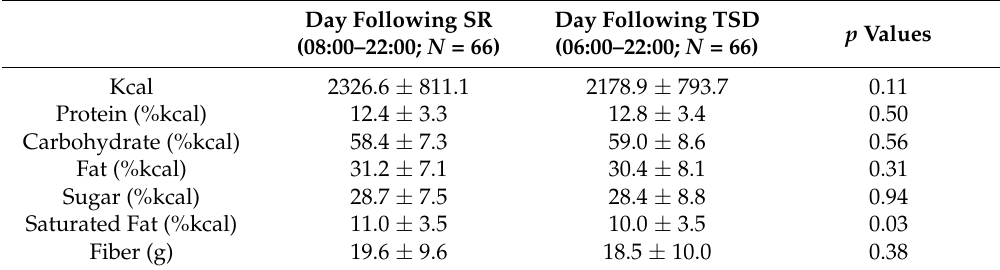
Table 2. Mean ± SD daily intake during the day following sleep restriction (SR) and the day following total sleep deprivation